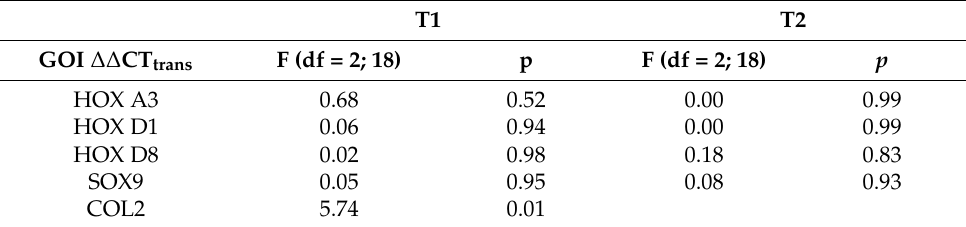
Table 7. One-way ANOVA with F-values and significance levels ( p ) for the time points T1 and T2 between the three locations.